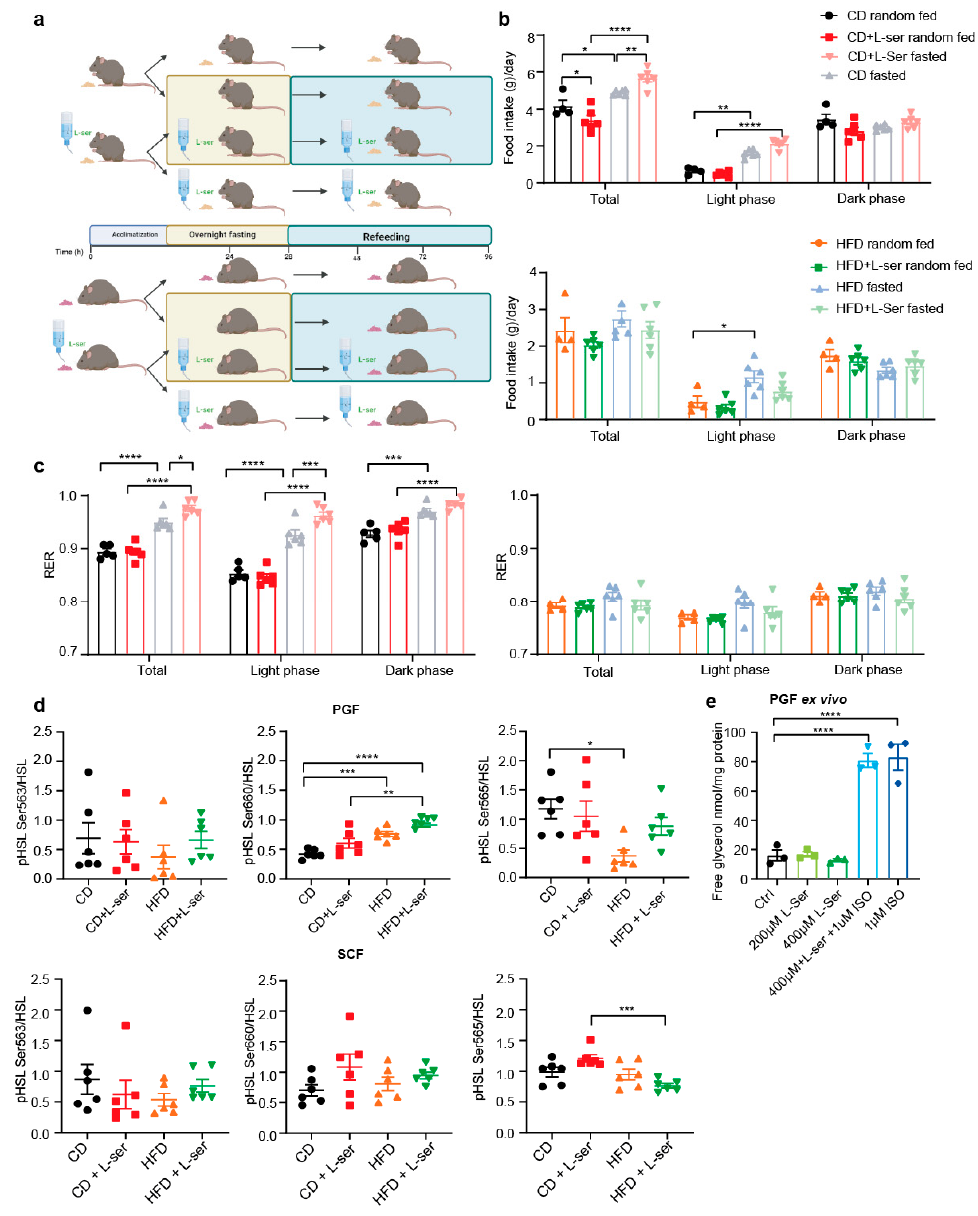
Figure 3. L-serine supplementation alters food intake and respiratory exchange ratio (RER), but not white adipose tissue (WAT) lipolysis. ( a ) Experimental setup for indirect calorimetry measurements. The figure was generated using Biorender.com. ( b ) Average food intake of random fed and fasted chow diet (CD) and high-fat diet (HFD)-fed mice with or without L-serine supplementation at week 7 (CD) or 8 (HFD) (CD random fed: n = 5; CD fasted, CD+L-ser random fed, CD+L-ser fasted: n =